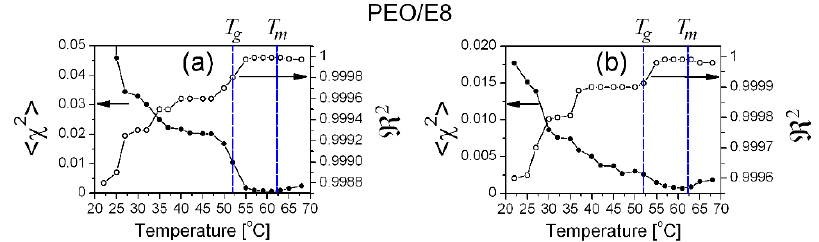
Figure 21. The values of the reduced < χ 2 > factor (the coefficient of determination of fit) and the (cid:0) (cid:60) 2 (cid:1) regression coefficient (the goodness of fit) against the temperature, for fits of the ε ″ ( f ) spectra of PEO/E8 obtained using: ( a ) Equation (3); ( b ) Equation (6).